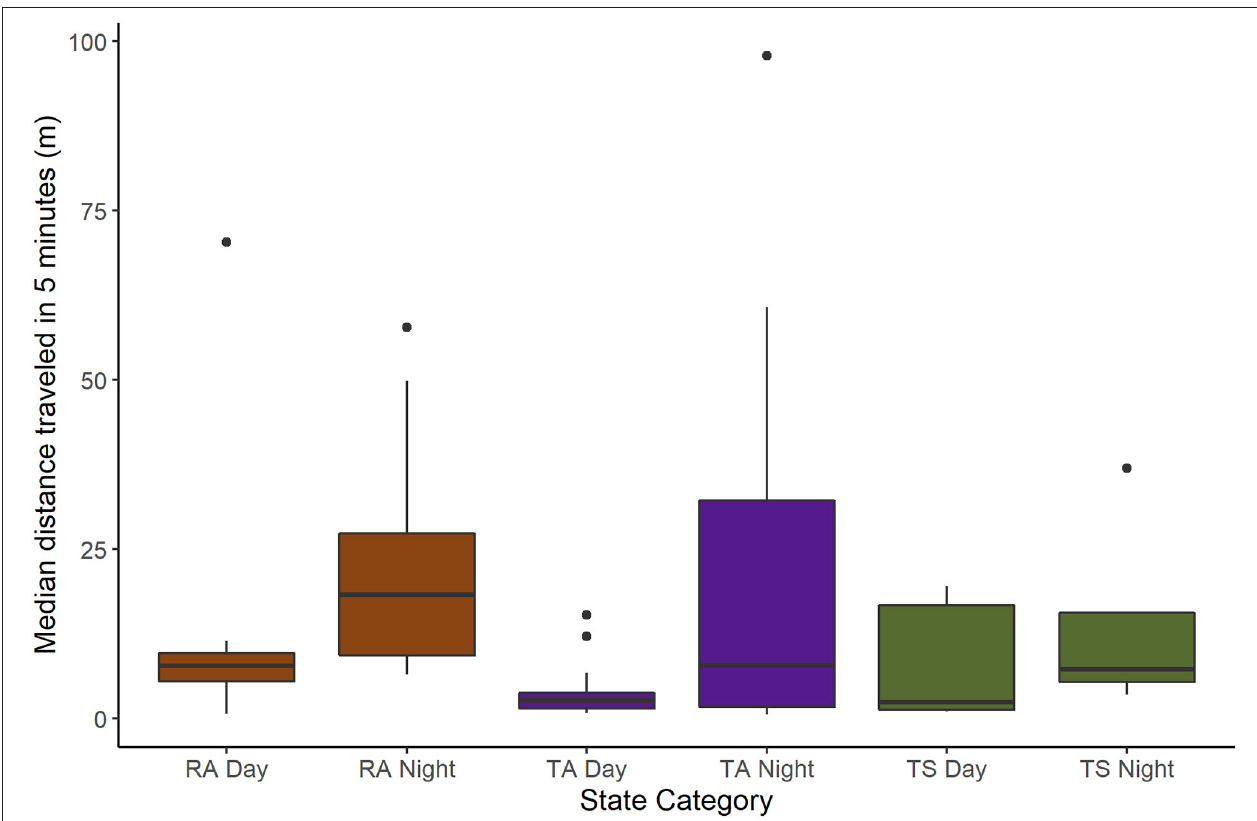
FIGURE 6 | Median distance traveled in 5-min intervals during 60-min sampling sessions for beavers monitored in the Price, San Rafael, and Green Rivers, Utah, USA, from May 2019 through October 2020. Observations are separated by time of sampling session (day or night) per beaver state category (RA, resident adult; TA, translocated adult; TS, translocated subadult). The boxes encompass the first through third quartiles (25–75 percentiles), while the whiskers extend to the highest or lowest values within 1.5 times the inter-quartile range (the distance between the first and third quartiles). Median distances traveled in 5min outside of this range are outliers and plotted as